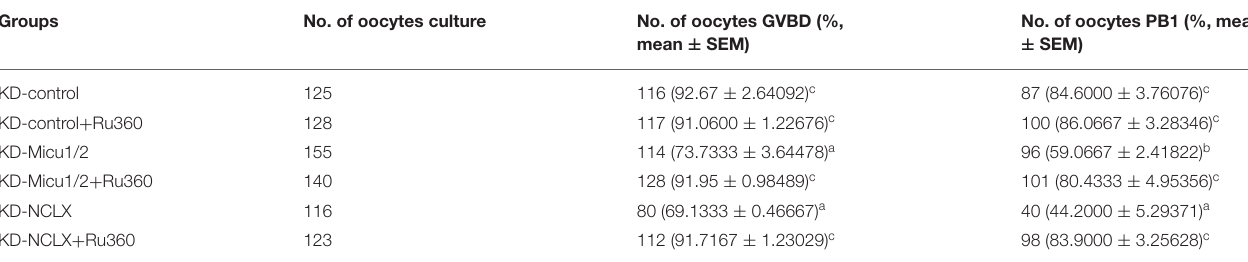
TABLE 1 | Effect of Ru360 treatment on recover meiosis maturation of mitochondrial calcium overload oocytes.